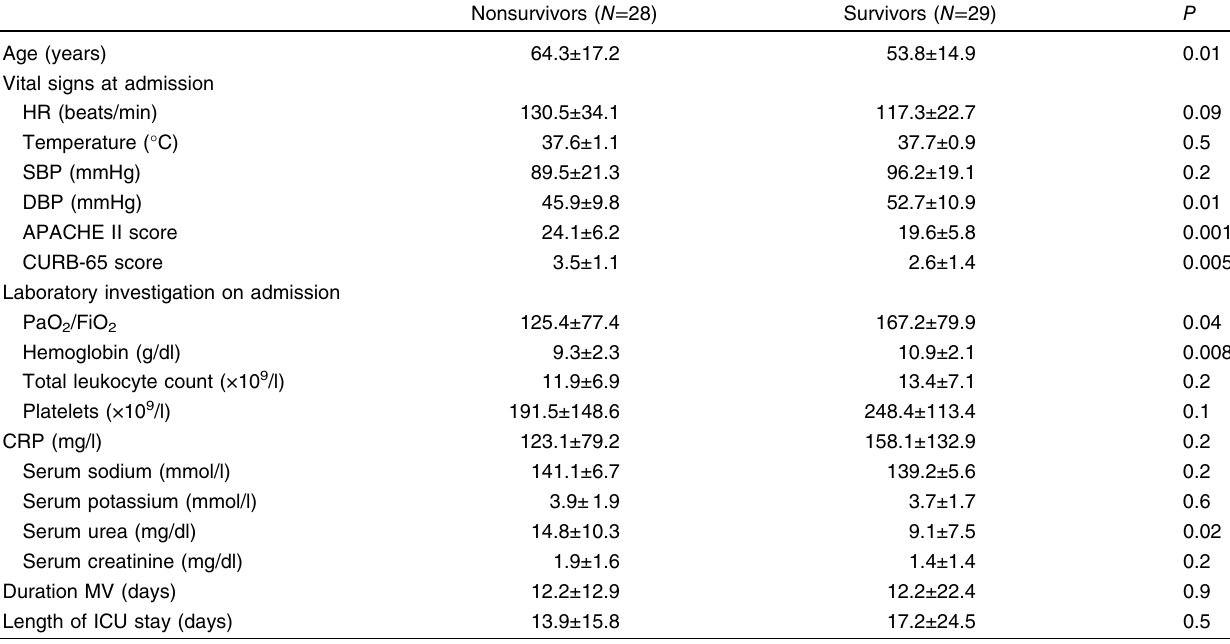
Table 3 Comparison between surviving and nonsurviving patients with severe CAP